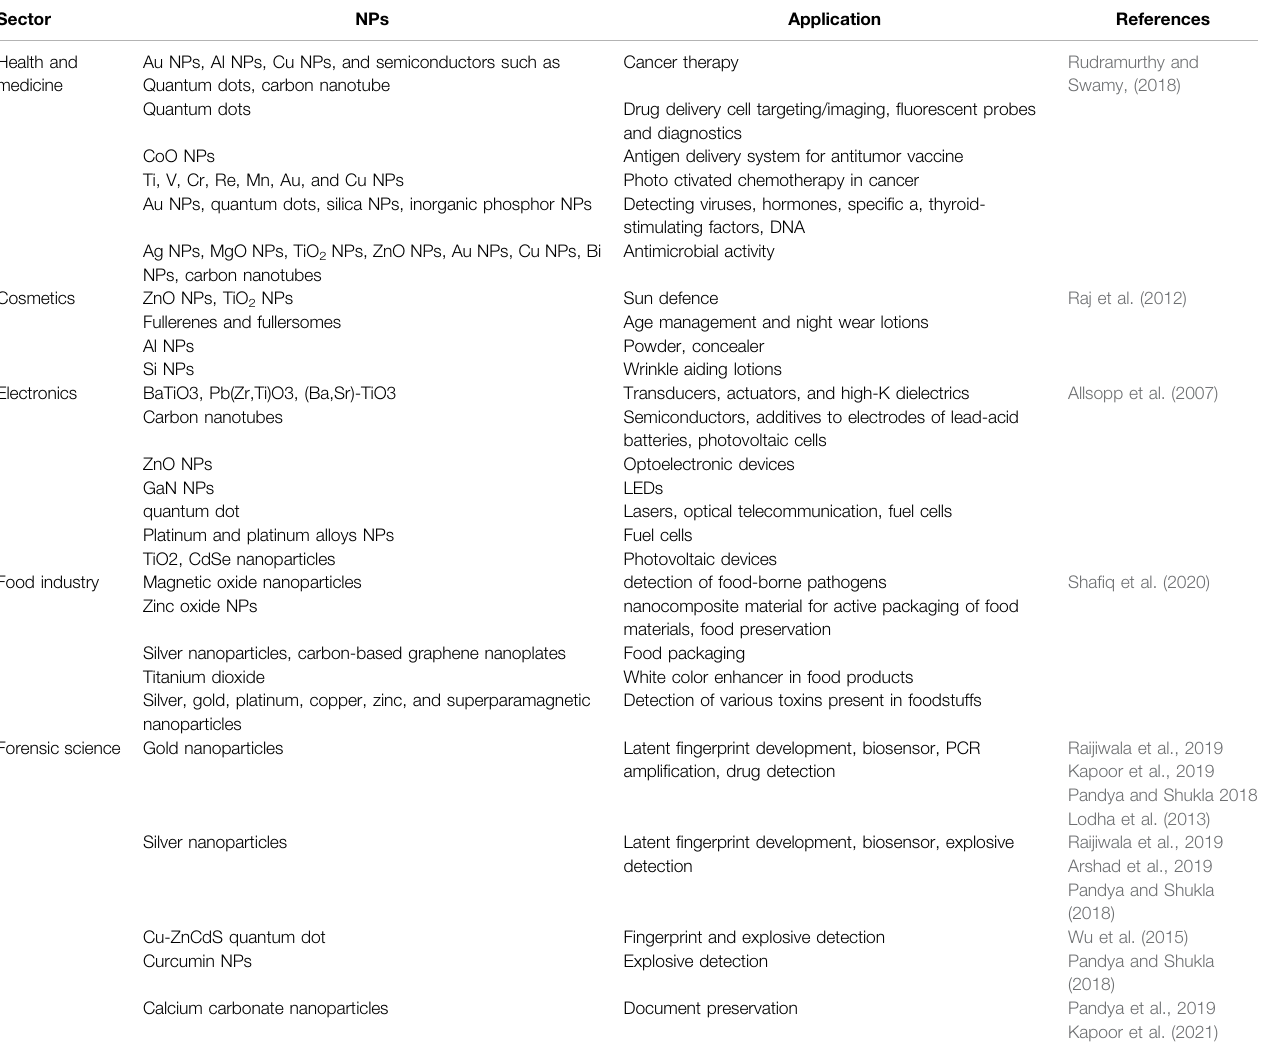
TABLE 1 | The broad application of commonly used nanoparticles